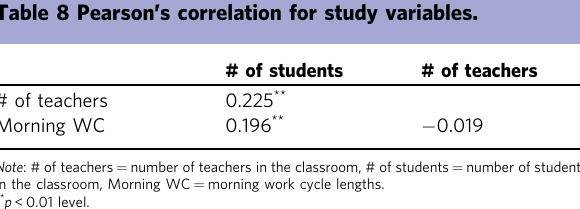
Table 8 Pearson ’ s correlation for study variables.